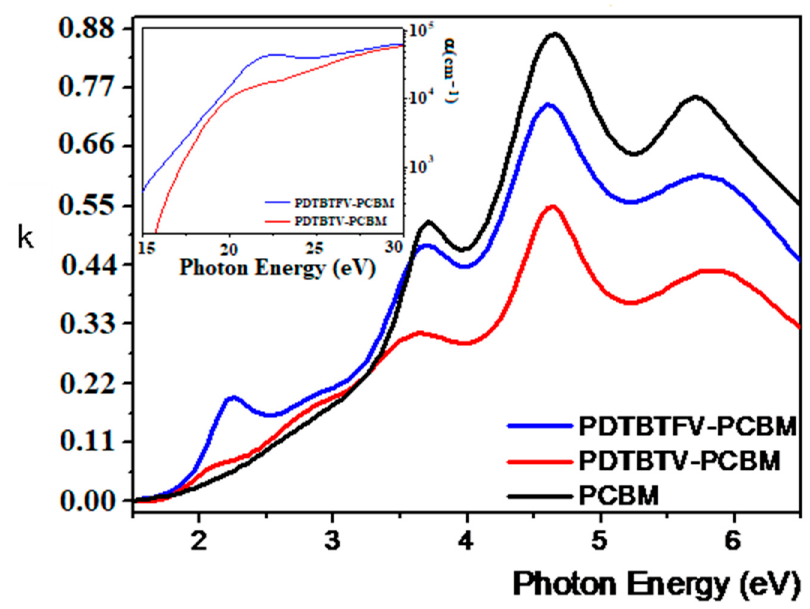
Figure 3. Ellipsometric spectra of the extinction coefficient, and in the inset, of the absorption coefficient for the fluorinated PDTBTFV and non-fluorinated PDTBTV polymers blended with PCBM (polymer/PCBM ratio 1:1 for both blends). For comparison, the spectrum of PCBM is also shown. Reprinted (adapted) with permission from ref. [31]. Copyright {2014} The Royal Society of Chemistry.